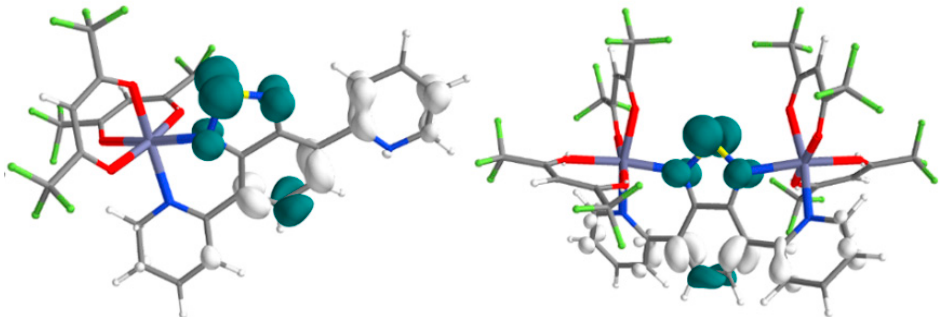
Figure 10. Representation of the Electron Density Differences (EDD) for the S 1 -S 0 transition of complex 1 ( left ) and the S 5 -S 0 transition of complex 2 ( right ). The excited electron and hole regions are indicated by, respectively, blue and white surfaces.